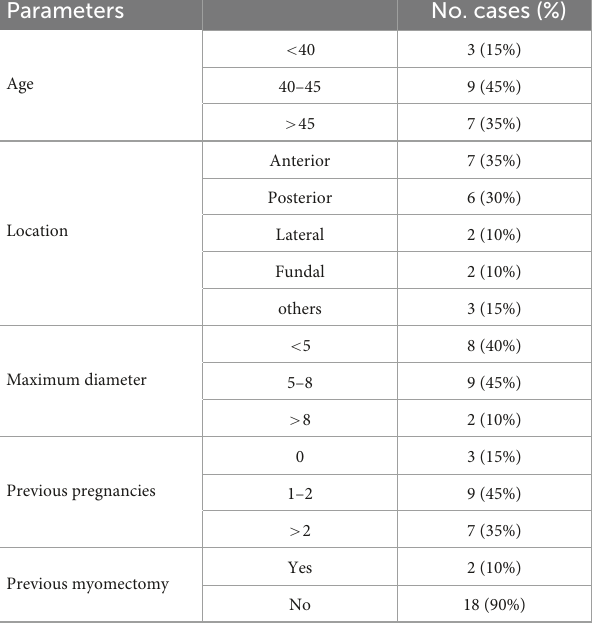
TABLE 2 Baseline characteristics of the study patients ( n = 20). Parameters No. cases